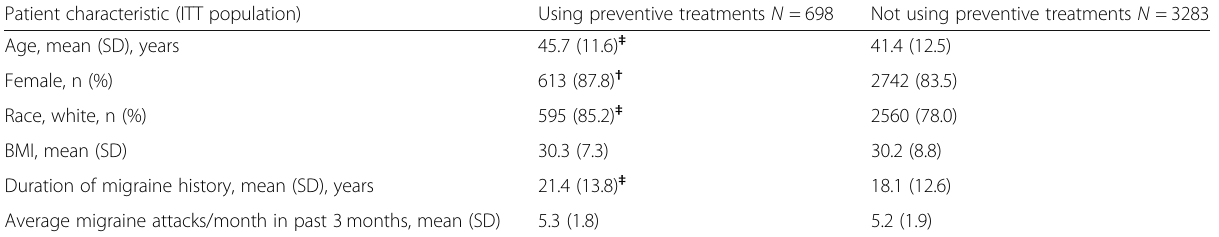
Table 1 Demographic characteristics of patient groups using and not using migraine preventive treatments Patient characteristic (ITT population) Using preventive treatments N =